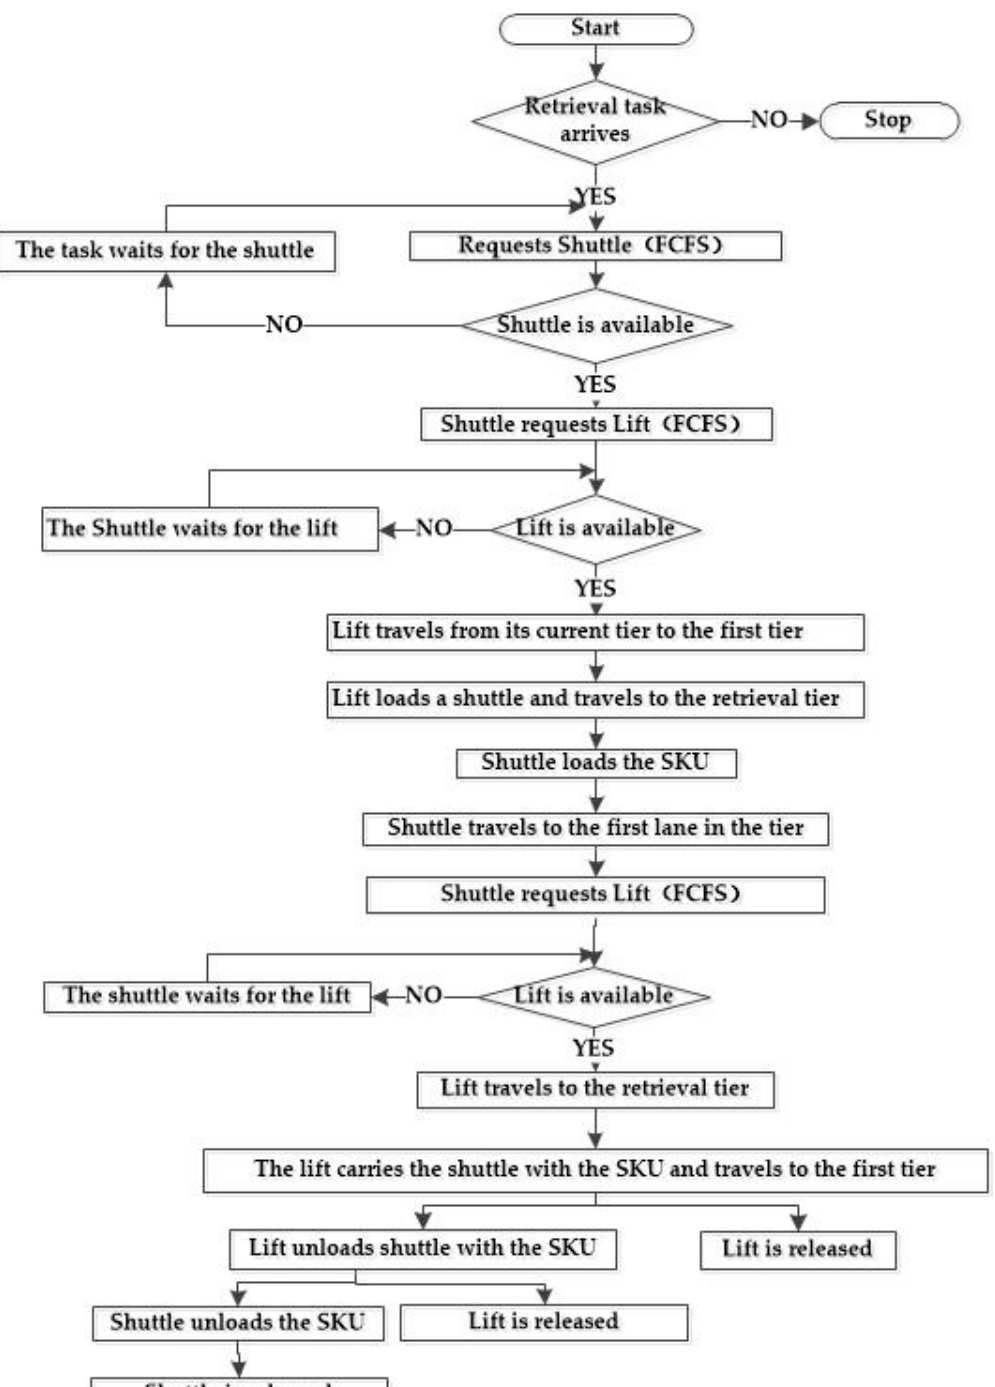
Figure 2. Flowchart of the retrieval operation in a tier-to-tier SBS/RS.